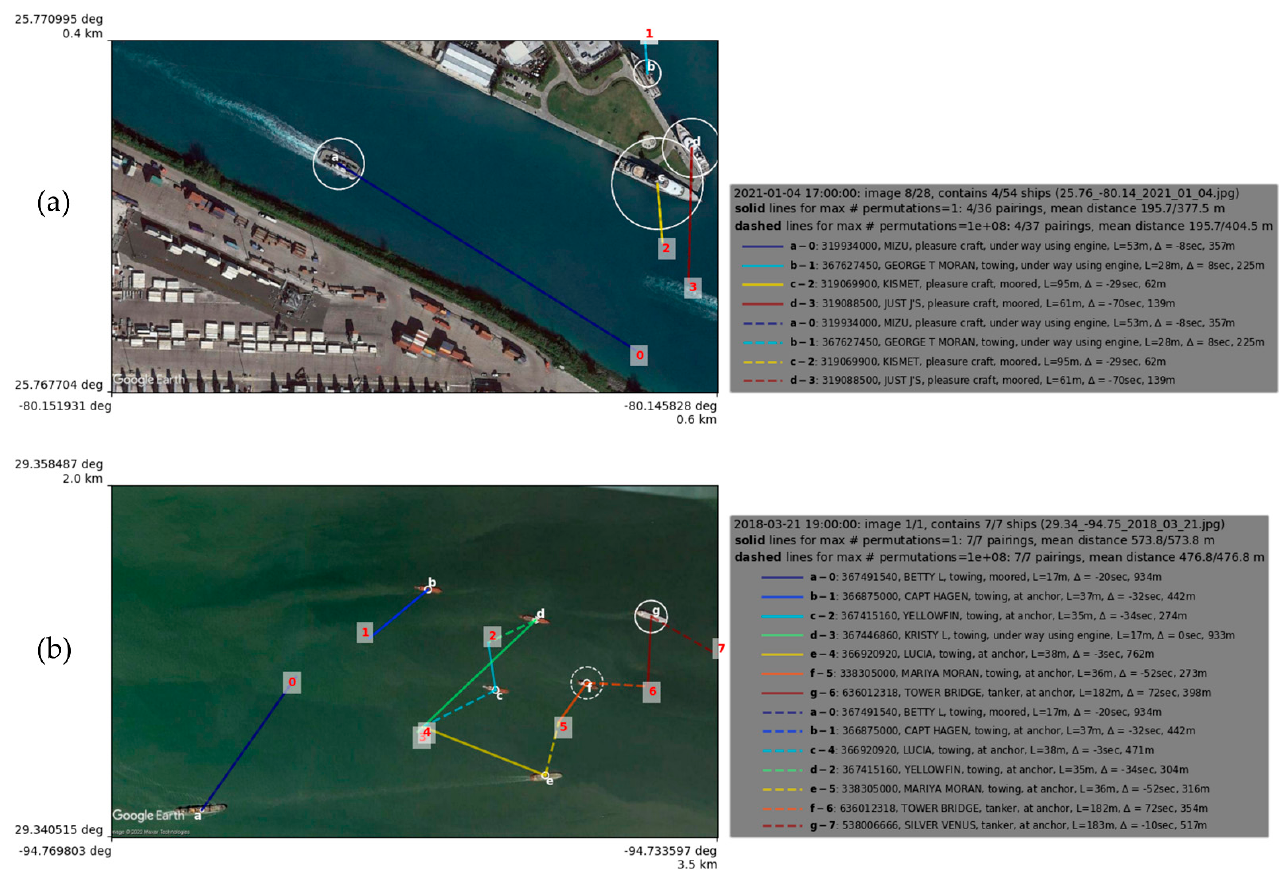
Figure 4. Examples of the ship − pairing algorithm, working against the Google Earth EO dataset and the Marine Cadastre AIS data. Each ship within the image is labeled with a letter, while each AIS message within the confines of the image is labeled by a number. Solid lines represent ship pairings when P max = 1 (Greedy Approach) and dashed lines represent ship pairings when P max = 10 8 . ( a ) An example in which both the greedy and extensive approaches agree on the ship pairings within the image. All four ships within the image are paired to the same AIS messages by both techniques.